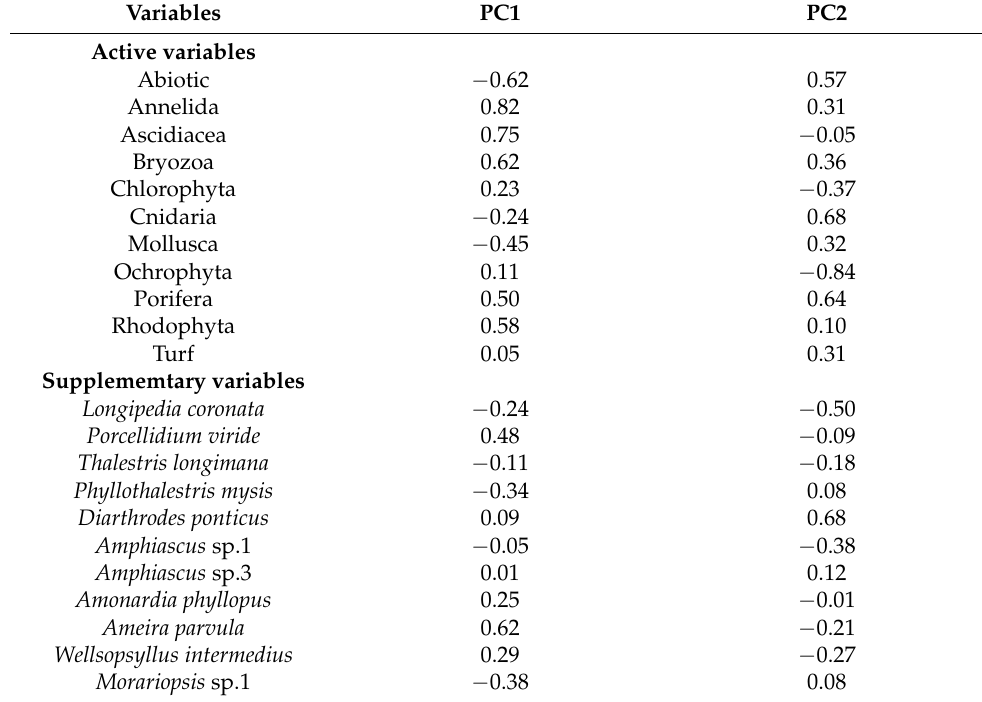
Figure 3. Mean values (± standard deviation) of the number of copepod species, Shannon-diversity and Pielou-evenness for sampling site ( a ), season ( b ) and depth ( c ). Table 2. Factor coordinates of the active and supplementary variables obtained by the Principal Component Analysis